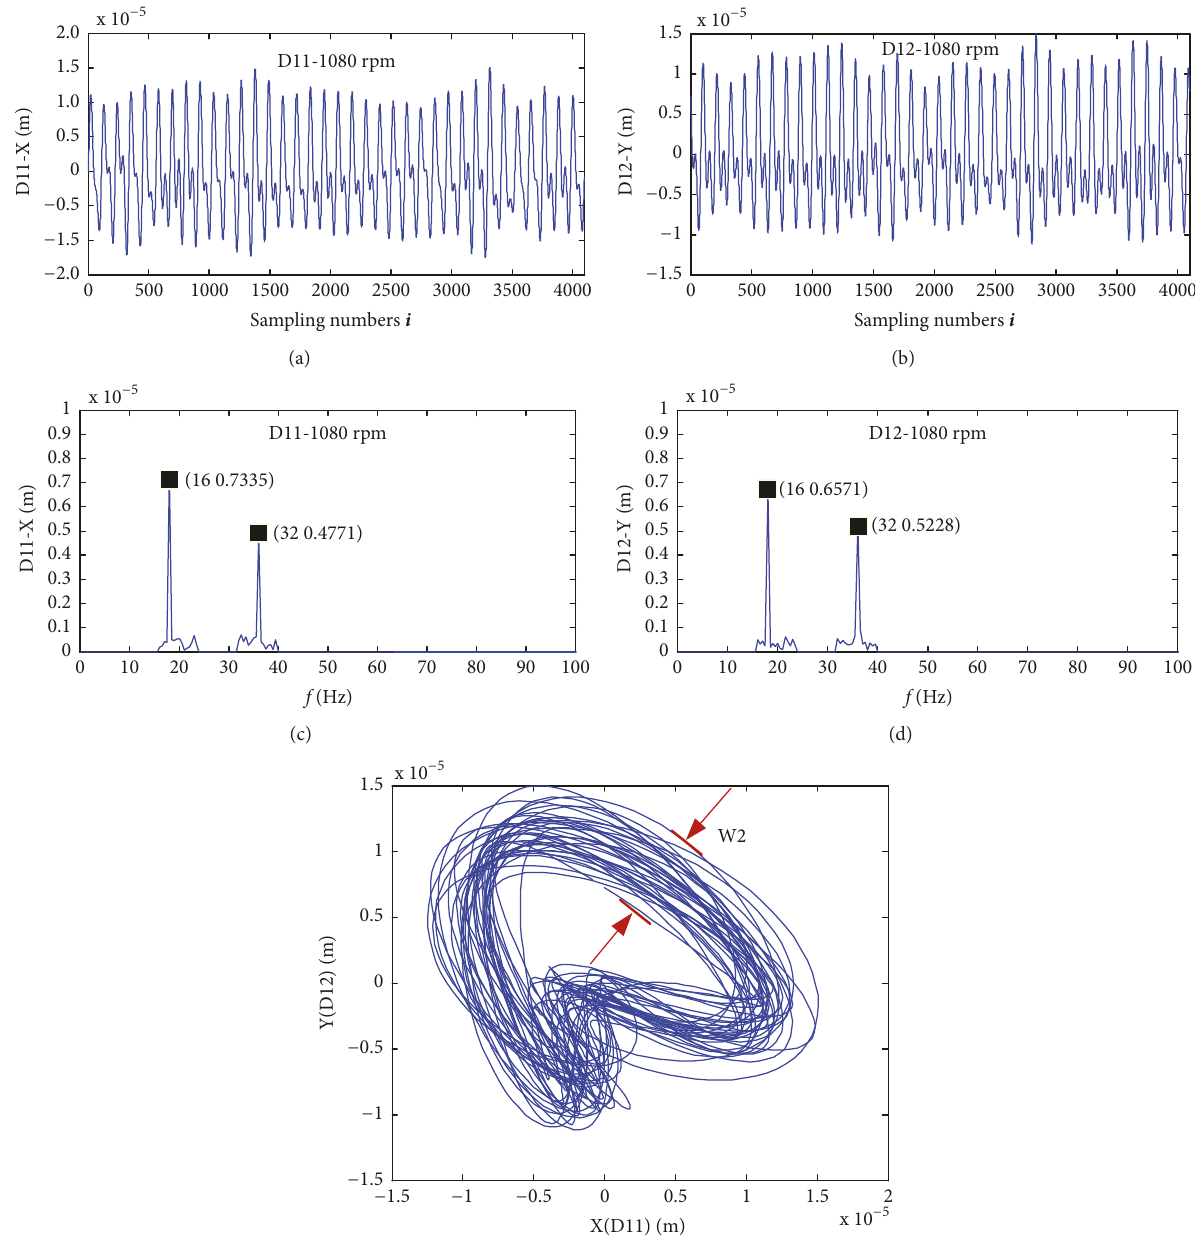
Figure 20: The purification effect of harmonic wavelets. (a) The time domain of D11. (b) The time domain of D12. (c) The frequency spectrum of D11. (d) The frequency spectrum of D12. (e) The orbit is to extract the first 2 frequencies.